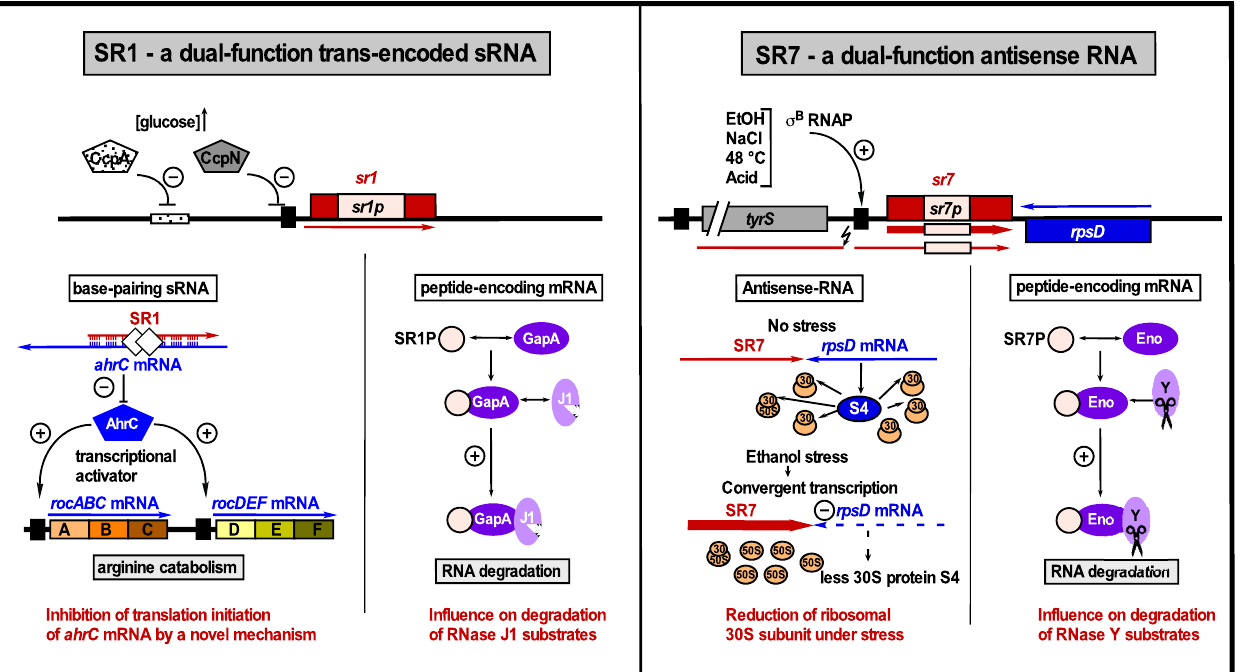
Figure 3. Two dual-function regulatory RNAs from B. subtilis , SR1 and SR7. Left: SR1 acts on the one hand as base-pairing sRNA in arginine catabolism by inhibiting translation of ahrC mRNA encoding the transcriptional activator of the arginine catabolic operons and on the other hand as mRNA encoding SR1P that modulates the B. subtilis DLN (degradosome-like network) by interacting with GapA to promote the GapA-RNase J1 interaction and enhance the RNase J1 activity. Transcription of sr1 is repressed by CcpA and CcpN. The RNA chaperone CsrA (white diamonds) promotes the SR1- ahrC mRNA interaction (adapted with permission from [4]). Right: On the one hand, SR7 reduces by transcriptional interference the amount of the convergently transcribed rpsD mRNA and, on the other hand, encodes SR7P that also modulates the DLN by interacting with enolase, increasing the recruitment of RNase Y and enhancing the RNase Y activity. Black line, DNA; red and blue lines, antisense and target RNAs; pink rectangle, SR1P or SR7P ORF.